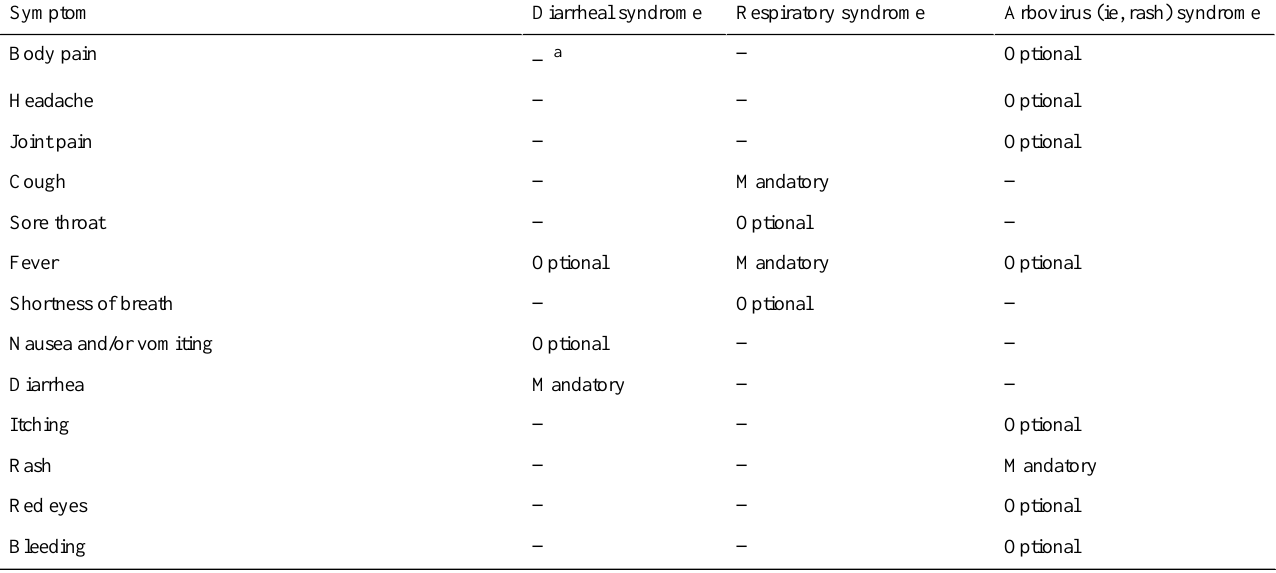
Table 1. Relationship between symptoms and syndromes.